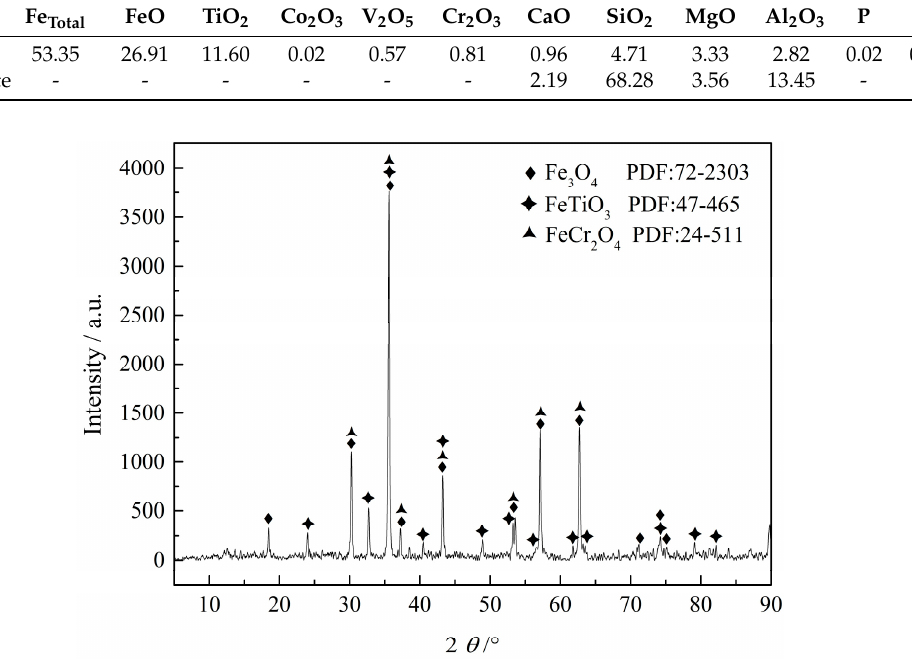
Figure 2. X-ray diffraction (XRD) pattern of chromium-bearing vanadium titanomagnetite (CVTM).